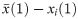
Influenceability over rounds and games.(A) Gauging game, (B) Counting game: distributions of the αi(1) influenceability after the first round and αi(2) influenceability after the second round for the time-varying influenceability model (1). The colormap corresponds to the average prediction RMSE of participants in each bin. For visualization purposes, one value at αi(1) = −1.5 has been removed from the histogram in the gauging game, round 1. (There was only one individual with αi(1) = −1.5. For this particular individual, the linear relationship between xi(2) − xi(1) and x¯(1)-xi(1) is not significant (p-val = 0.38), so that the coefficient αi(1) = −1.5 should not be interpreted. For the rest of the participants, the level of trust can be read from the color scale. The color of a bar corresponds to the average prediction error made for the participants with αi values falling within the bar range). (C) Cumulated distributions of αi(1) and αi(2) for each type of games.